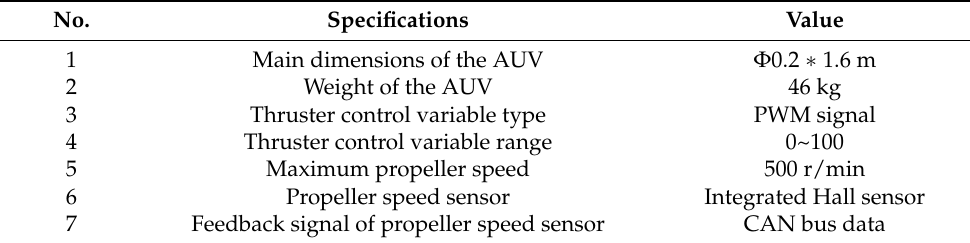
Figure 16. The portable AUV in sea trial. Table 3. Specifications of the portable